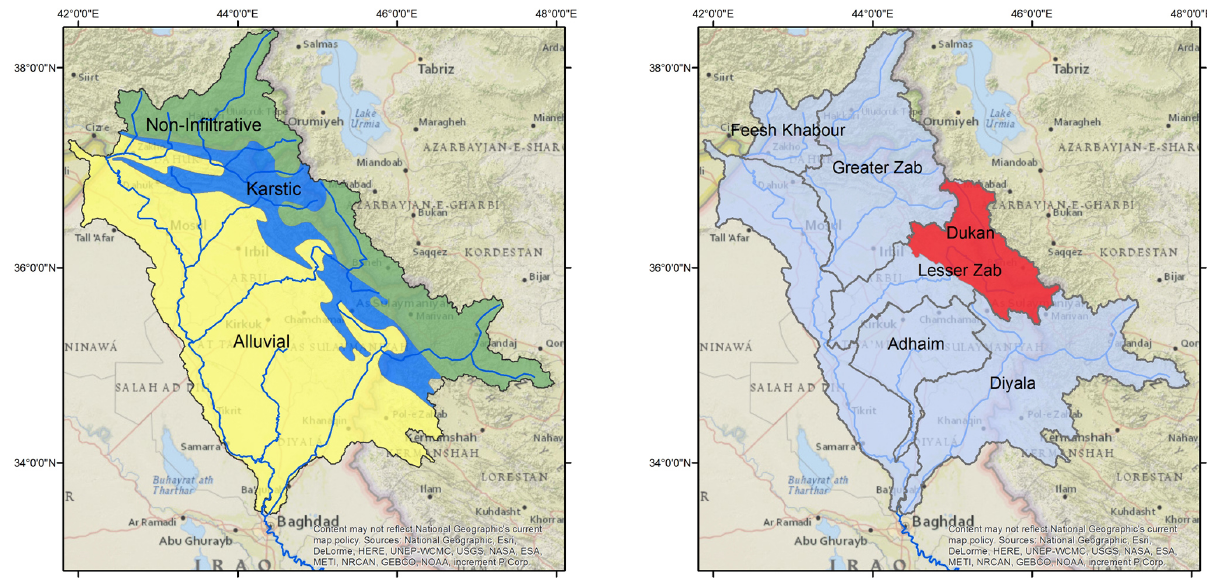
Figure 4. (left) Approximate division of northern Iraq into three geologic zones, mainly based on Stevanovic and Iurkiewicz (2008). (right) Boundaries of main tributaries of the Tigris in northern Iraq. The Dukan catchment, which is the upper part of the Lesser Zab catchment, is indicated in red. Calibration on streamflow is based on measurements from the Dukan area and calculation of water mass for the whole of northern Iraq is based on all